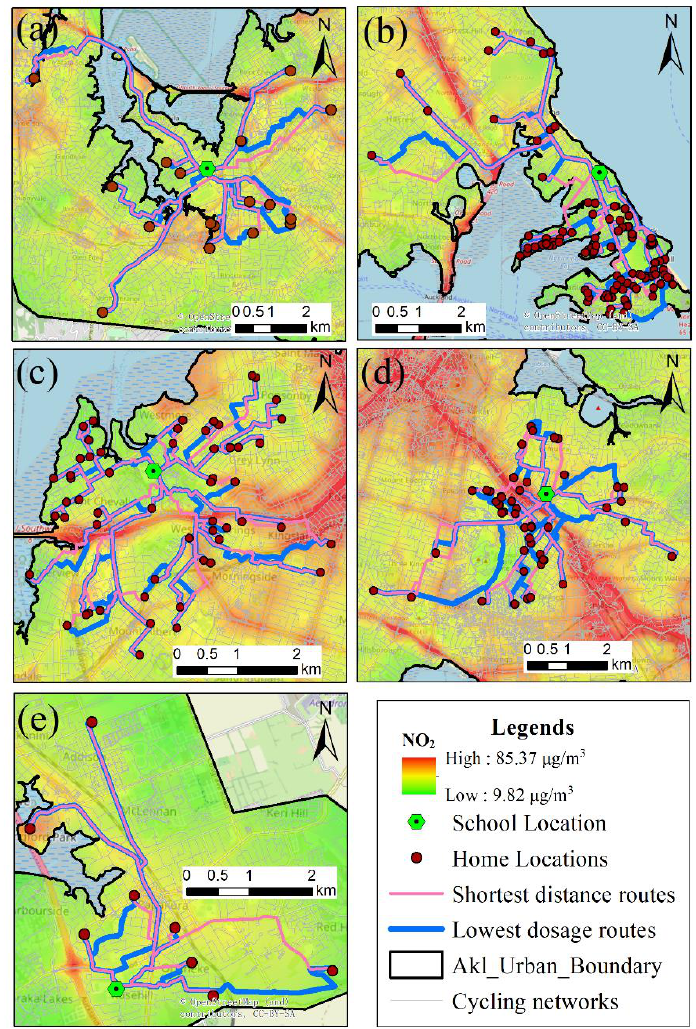
Figure 2. Visualization of route choices (shortest distance vs. lowest dose) for students in each school: ( a ) Avondale College; ( b ) Takapuna Grammar School; ( c ) Western Spring College; ( d ) Remuera Intermediate School; ( e ) Rosehill College.